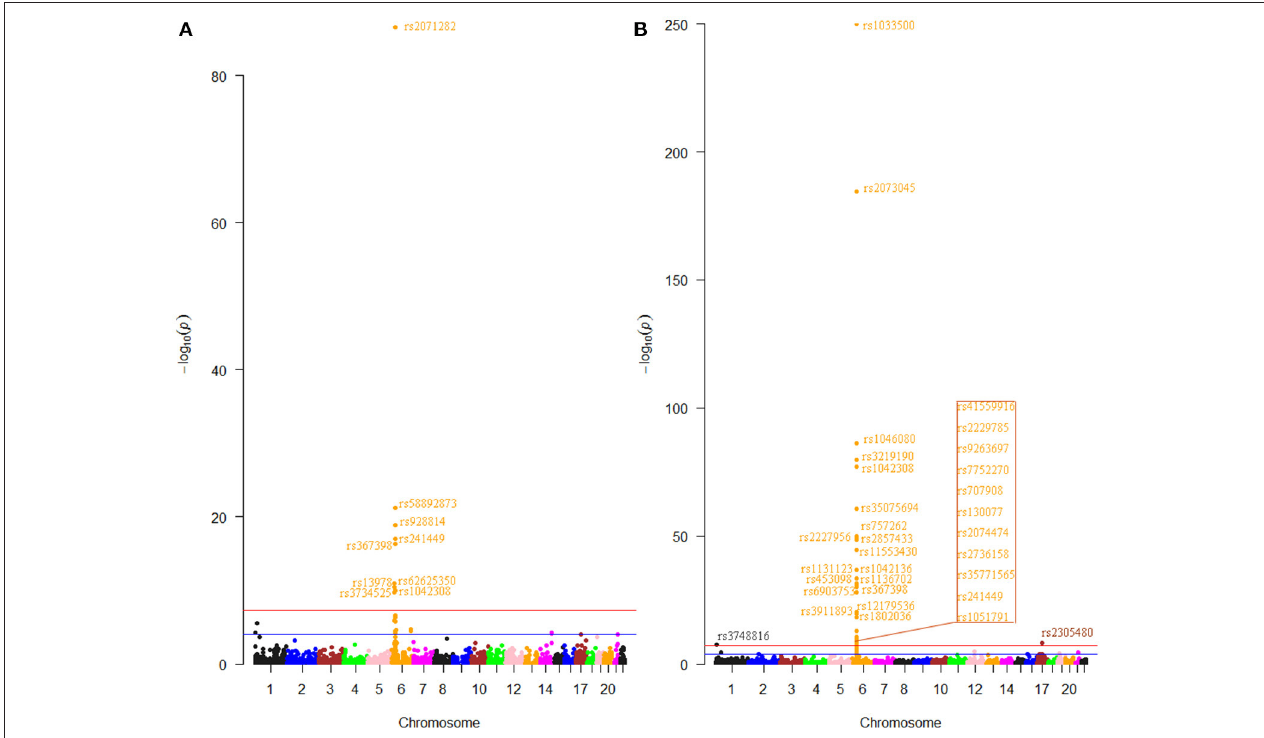
FIGURE 1 | Genome-wide results for the association between m 6 A-SNPs and RA. The Manhattan plots show –log 10 P values for the association of 2,672 m 6 A-SNPs with RA in Asians (A) and the association of 3,667 m 6 A-SNPs with RA in Europeans (B) . The data was from the RA GWAS published at 2014. SNPs reached the genome-wide significance level ( P < 5.0 × 10 − 8 ) were